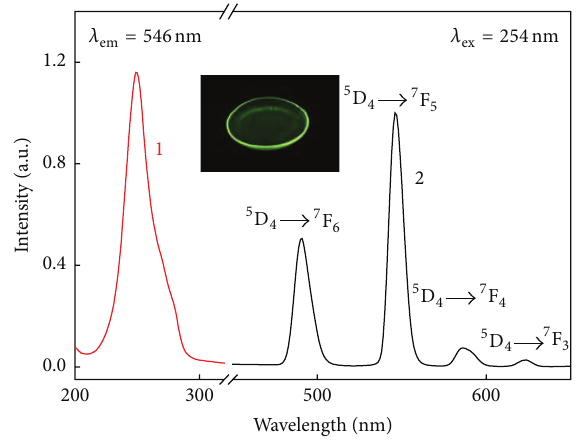
Figure 3: Excitation (curve 1) and emission (curve 2) spectra for 0.2 wt% TBA incorporated PMMA. Inserted photo: fluorescence from TBA incorporated PMMA under 254 nm UV